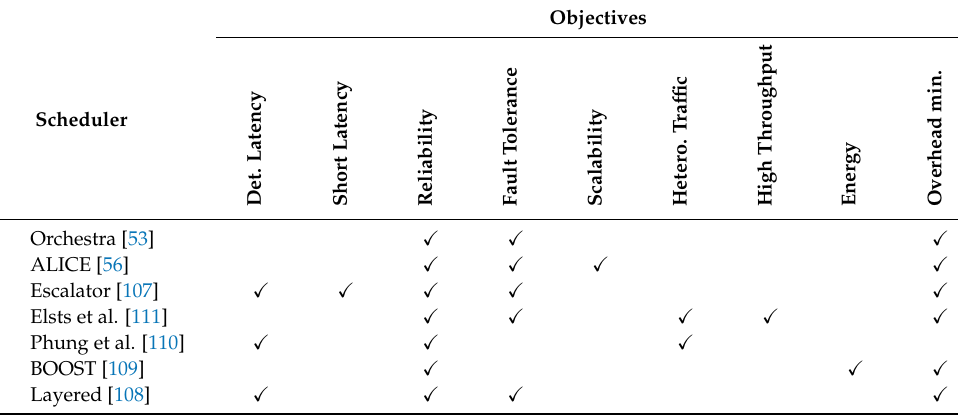
Table 6. Evaluation of autonomous TSCH